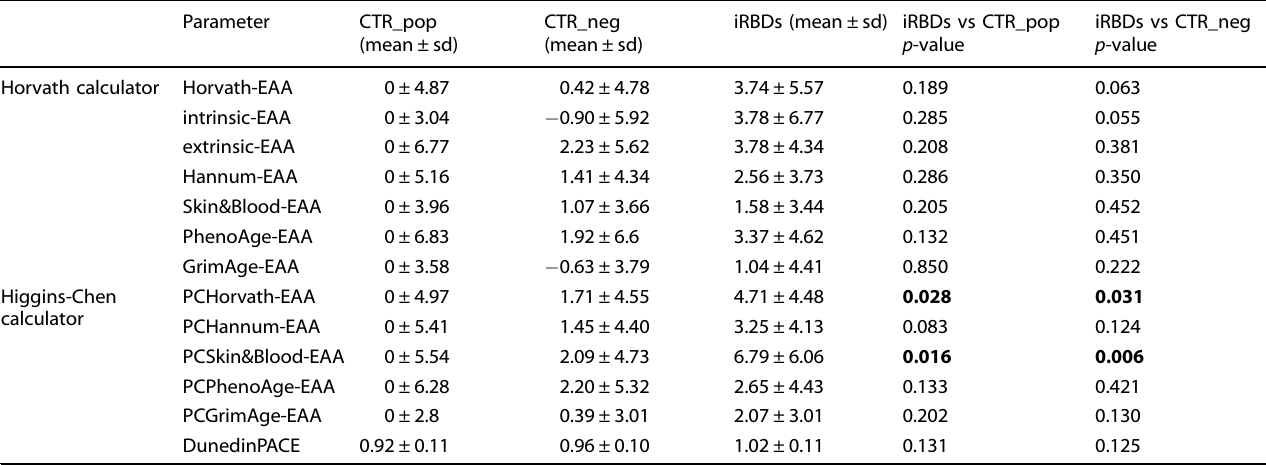
Table 1. Epigenetic Age Acceleration (EAA) measures in the study groups. Parameter